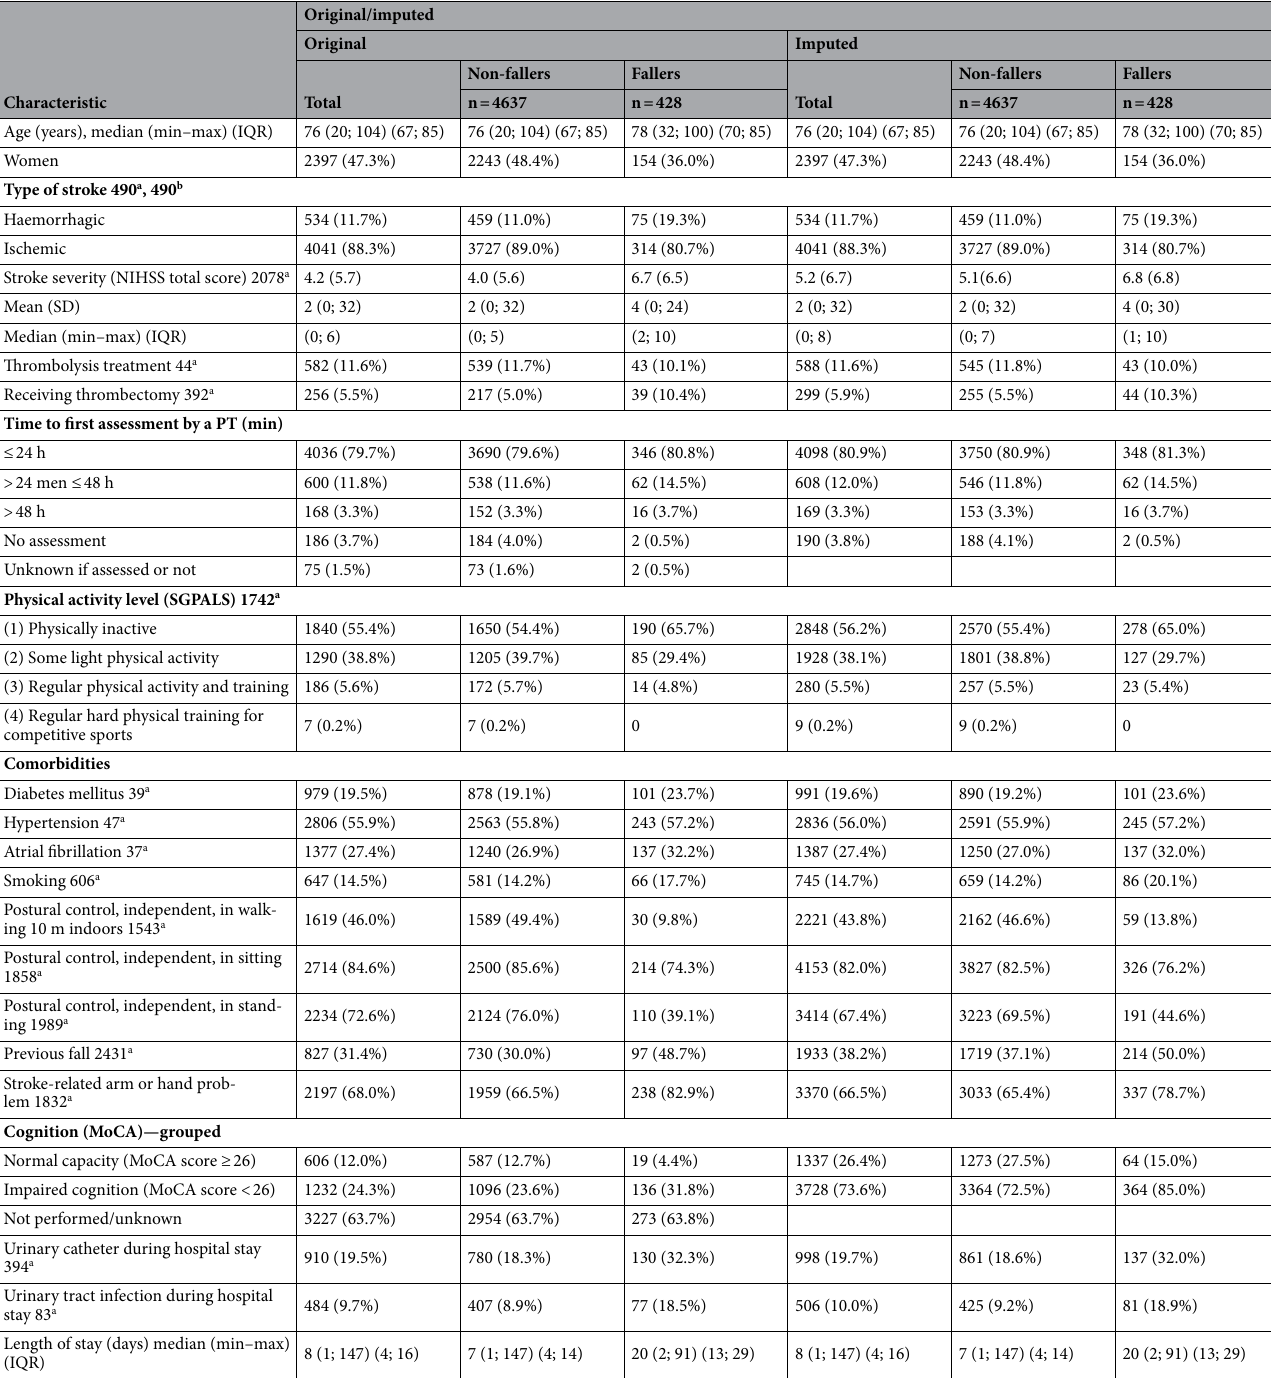
Table 1. Baseline characteristics, type of stroke and comorbidity among 5065 patients with acute stroke. For categorical variables, n (%) is presented. For continuous variables, the median (min; max) and (Q1; Q3) are presented. There was no imputation for the 490 individuals who did not have data on the type of stroke. IQR interquartile range, NIHSS the National Institute of Health Stroke Scale, PT physical therapist, SGPALS the Saltin-Grimby Physical Activity Scale, MoCA the Montreal Cognitive Assessment Scale. a Indicates the number of missing data before the imputation of missing data. b Indicates the number of missing data after the process of data